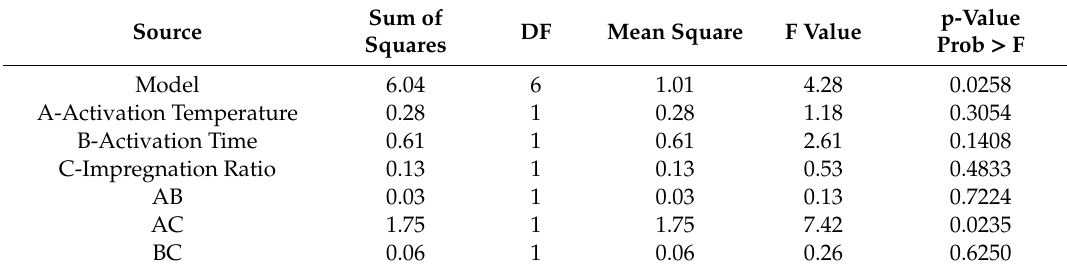
Table 4. ANOVA for removal % surface modified model.